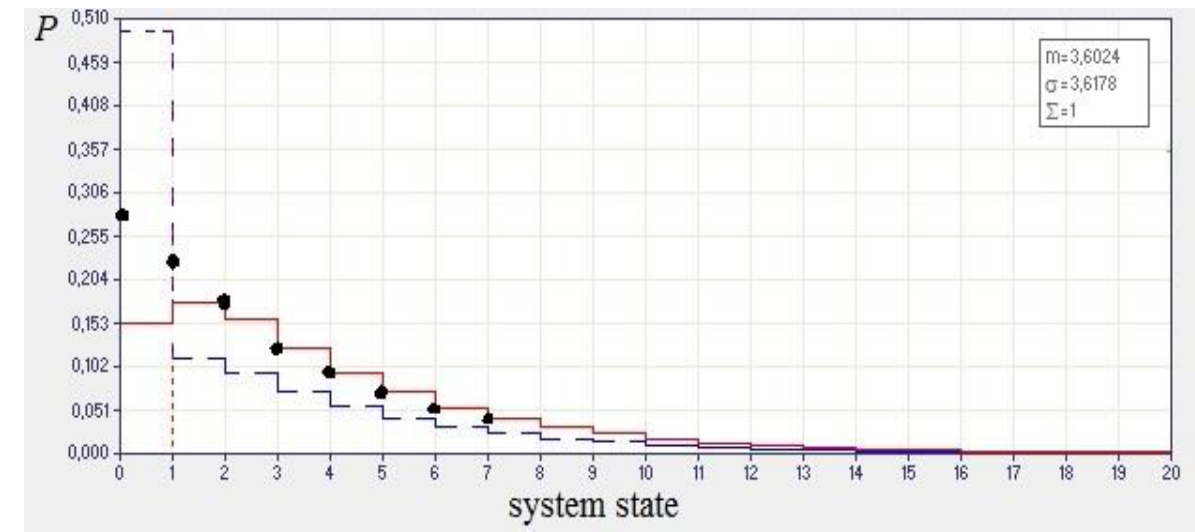
Figure 1. – Distribution functions of the system states and its